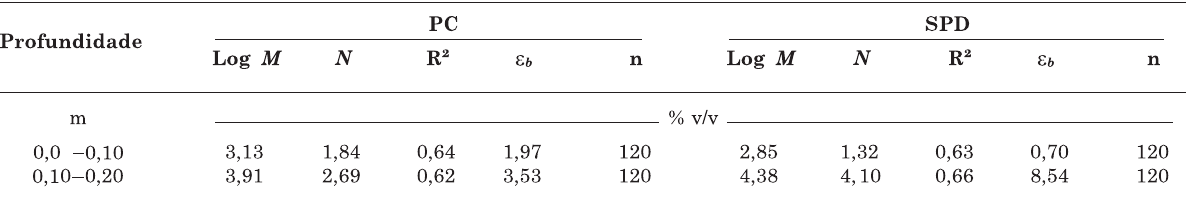
Figura 4. Relação logarítmica entre K Latossolo Vermelho distrófico para dois siste- mas de preparo do solo e duas